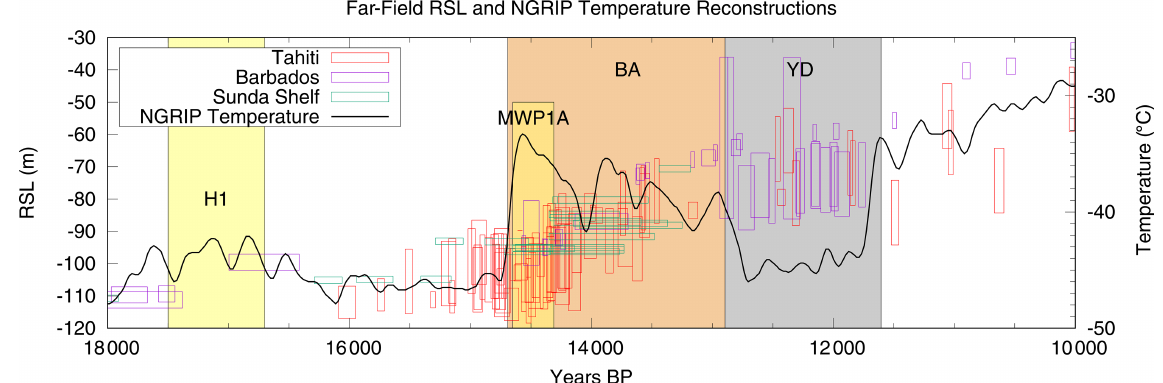
Figure 1. Far-field relative sea level records (i.e. sea level relative to the present day, where the far-field sea level signal is roughly comparable to the eustatic sea level) from Barbados (Fairbanks, 1989), Sunda Shelf (Hanebuth, 2000), and Tahiti (Deschamps et al., 2012) plotted along with a recent North Greenland Ice Core Project (NGRIP) temperature reconstruction for the deglacial (Kindler et al.,